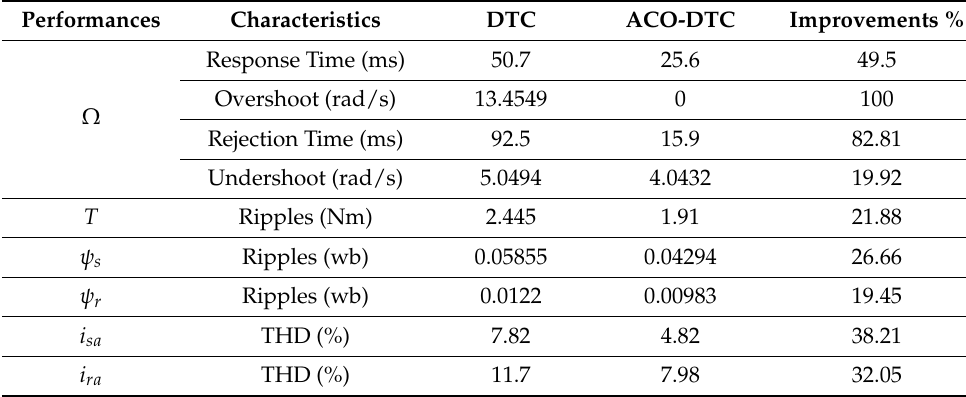
Table 4. Performances characteristics of the ACO-DTC and DTC.